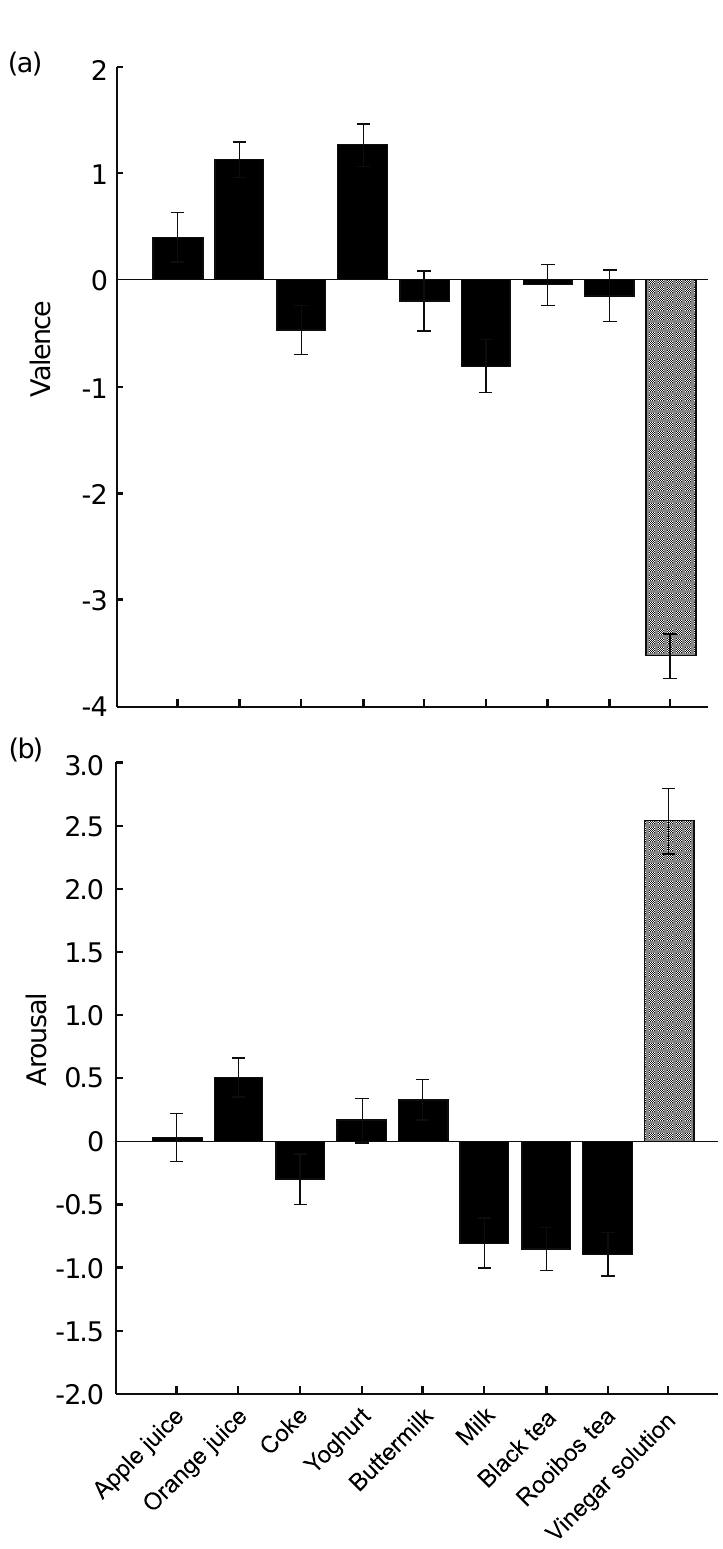
Figure 2. The results of explicit ratings: valence ( a ) and arousal ( b ) averaged across participants. Solid bars represent the eight regular drinks, and the dotted bar represents the vinegar